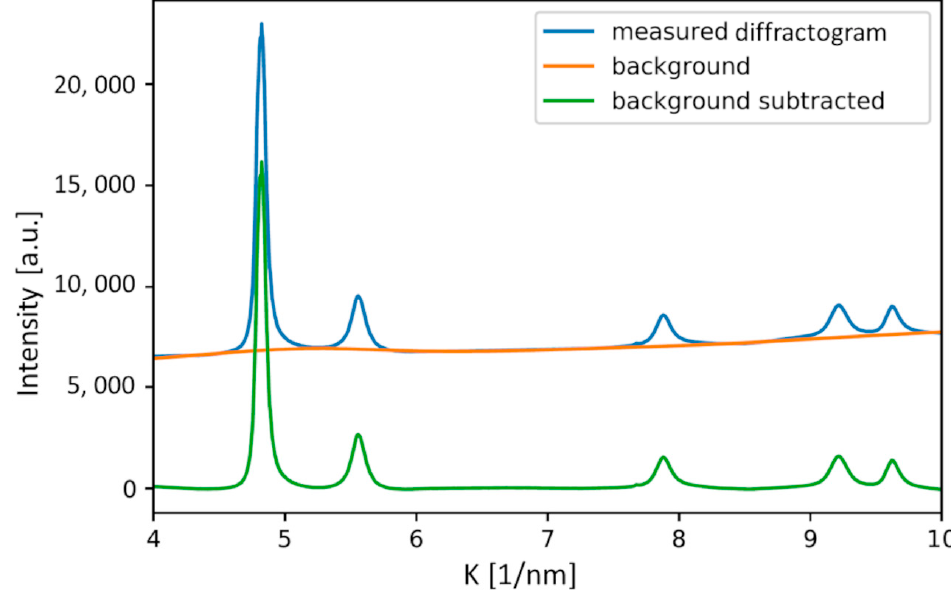
Figure 6. Illustration of the background subtraction for a measured FCC diffraction